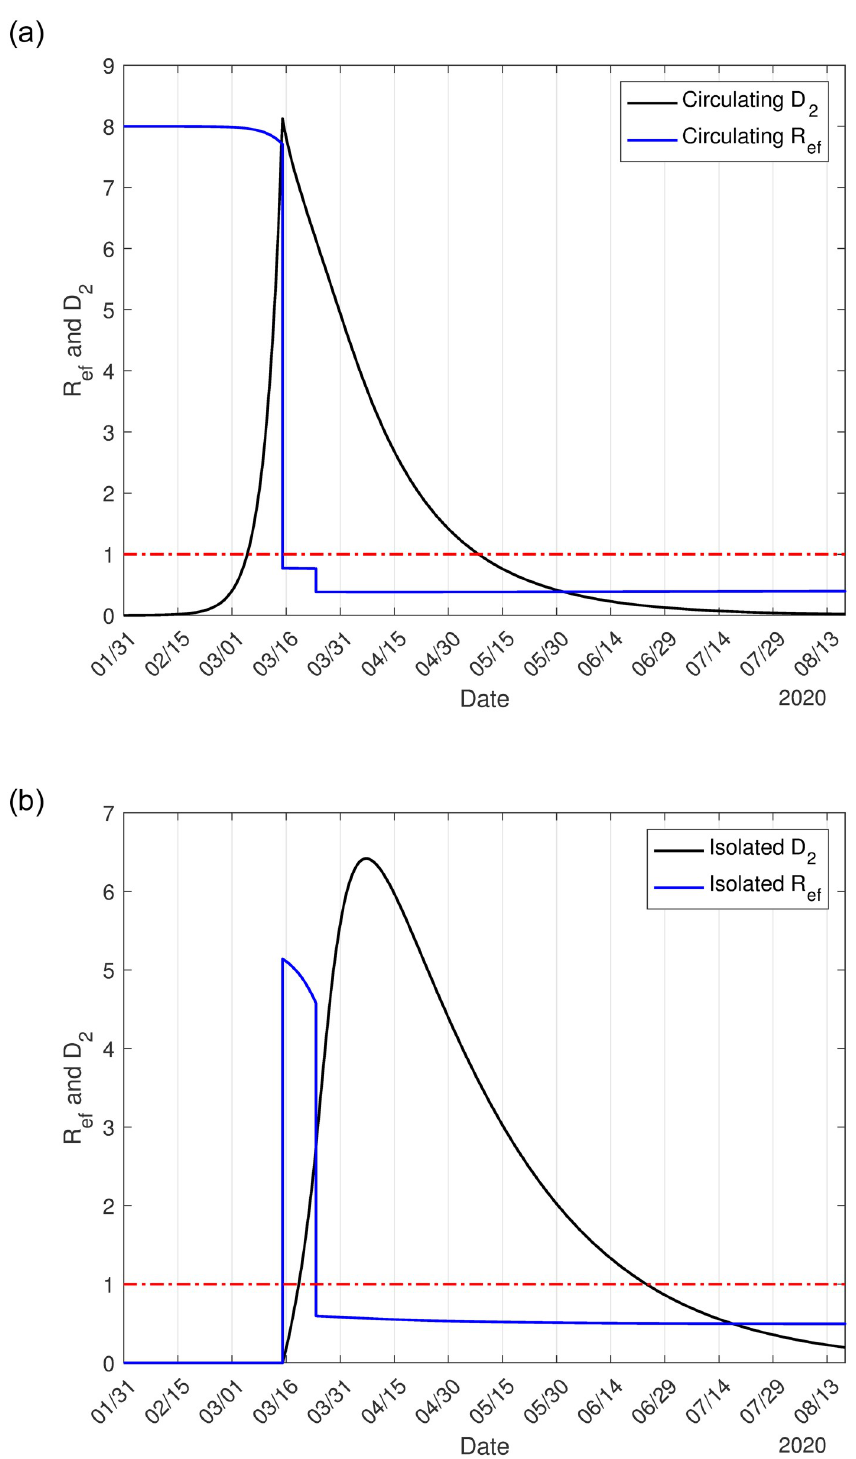
Fig 6. The effective reproduction number R ef for epidemic with lockdown in circulating (a) and locked-down (b) population in Spain. The number of severe covid-19 cases D 2 must be multiplied by 1, 000 (a) and 12, 000 (b).